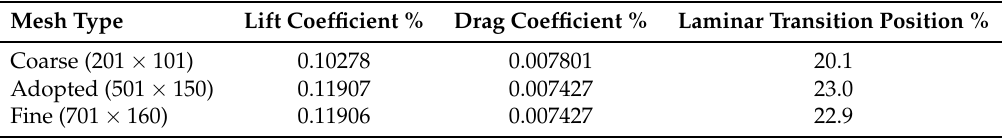
Figure 2. An illustration of the adopted mesh topology. Table 1. Comparison of mesh parameters and their CFD